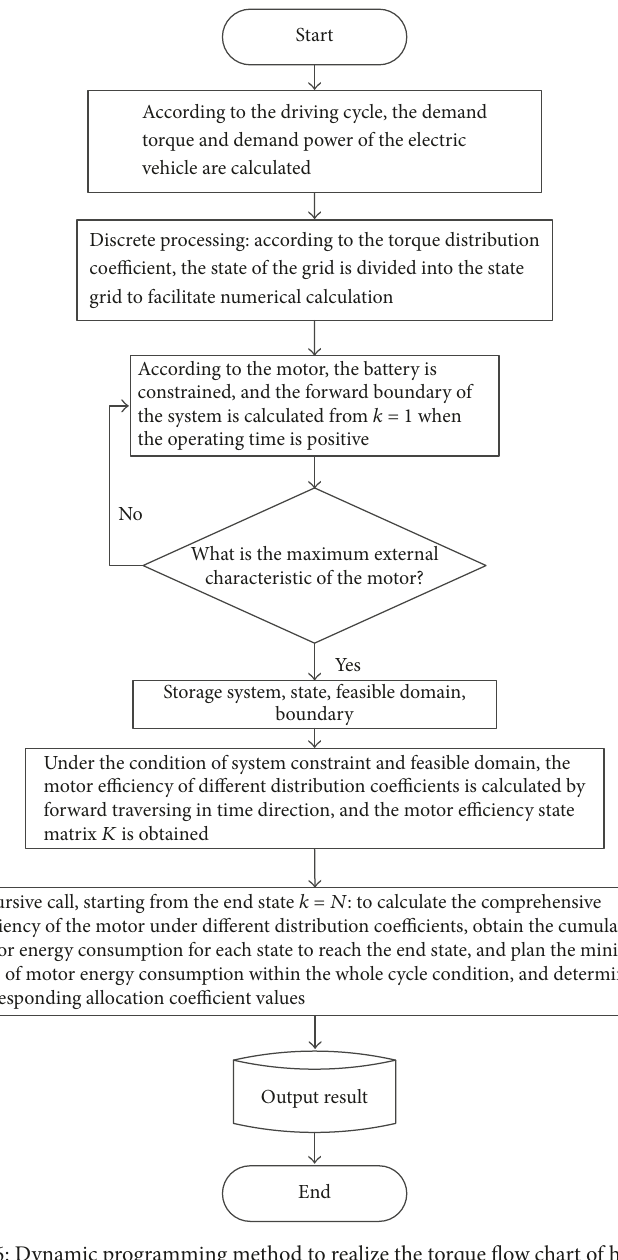
Figure 6: Dynamic programming method to realize the torque flow chart of hub motor.